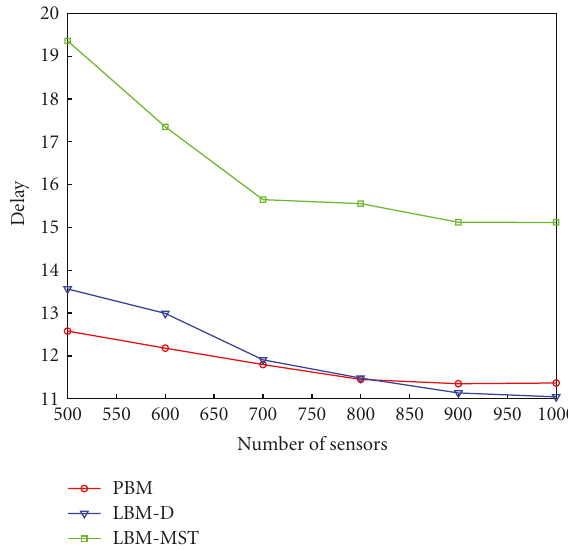
Figure 10: Average end-to-end delay for destinations grouped